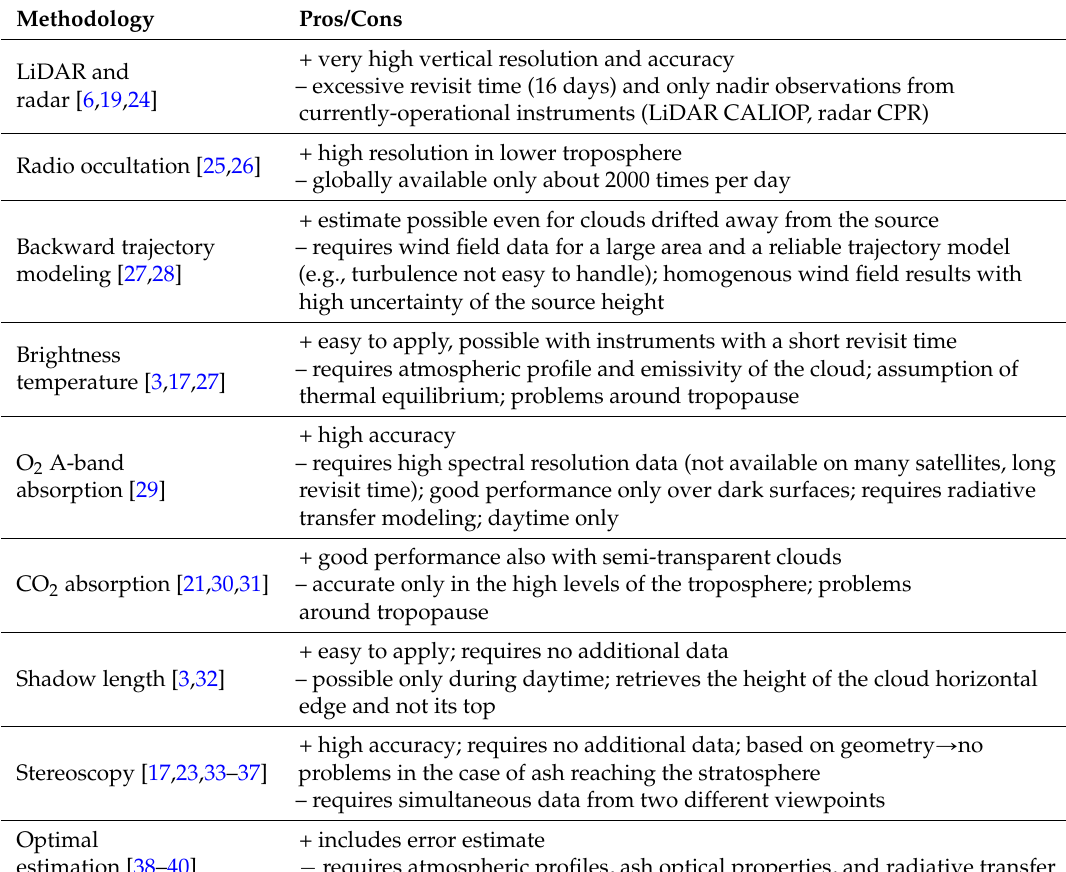
Table 1. Overview of satellite methods for cloud top height